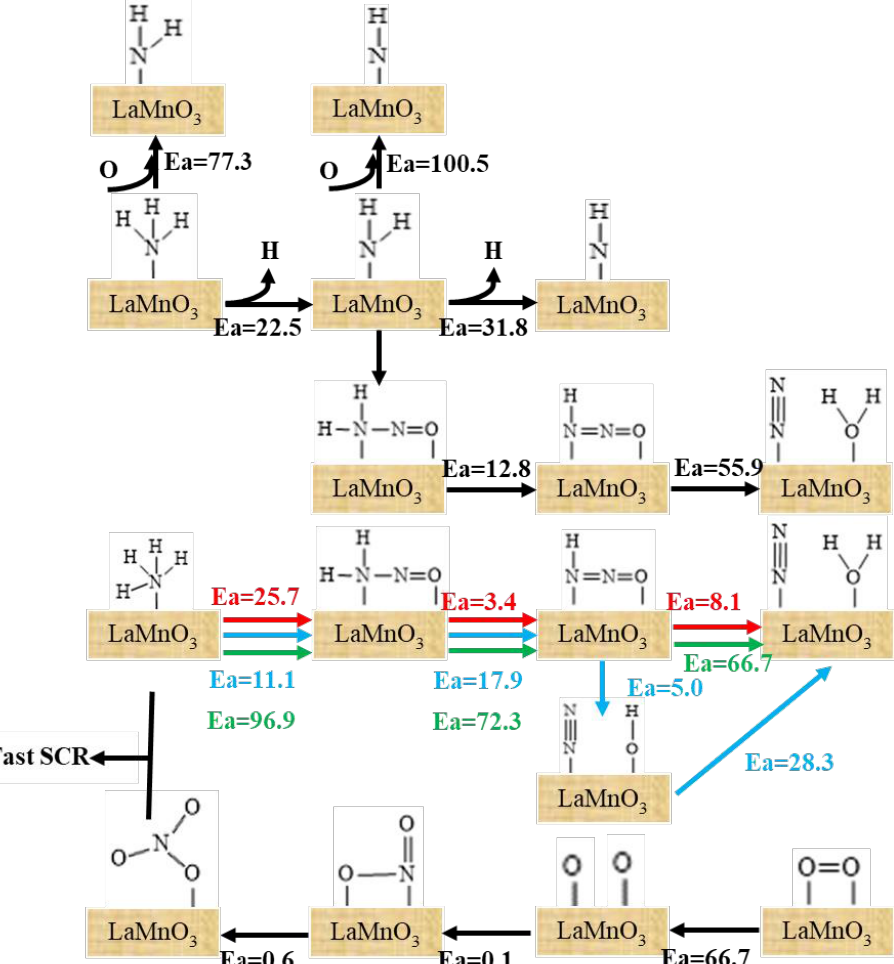
Figure 17. The reaction process analysis for NH 3 -SCR of NO with LaMnO 3 catalyst.